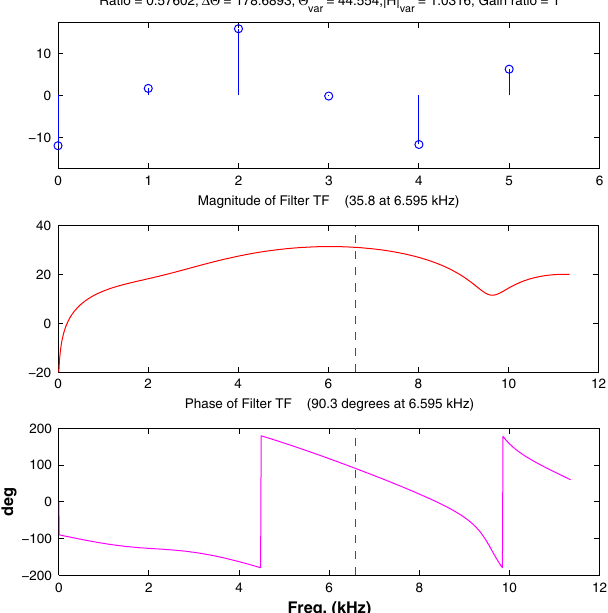
FIG. 3. (Color) Example DSP control filter implemented for each bunch in the PEP-II HER. This is a 6-tap FIR filter, optimized to have 35 dB gain at the 6.5 kHz synchrotron frequency with overall net 90 (cid:3) phase shift including system delays. The gain at 720 Hz is roughly 28 dB below the system operating gain and rapidly falls to zero at